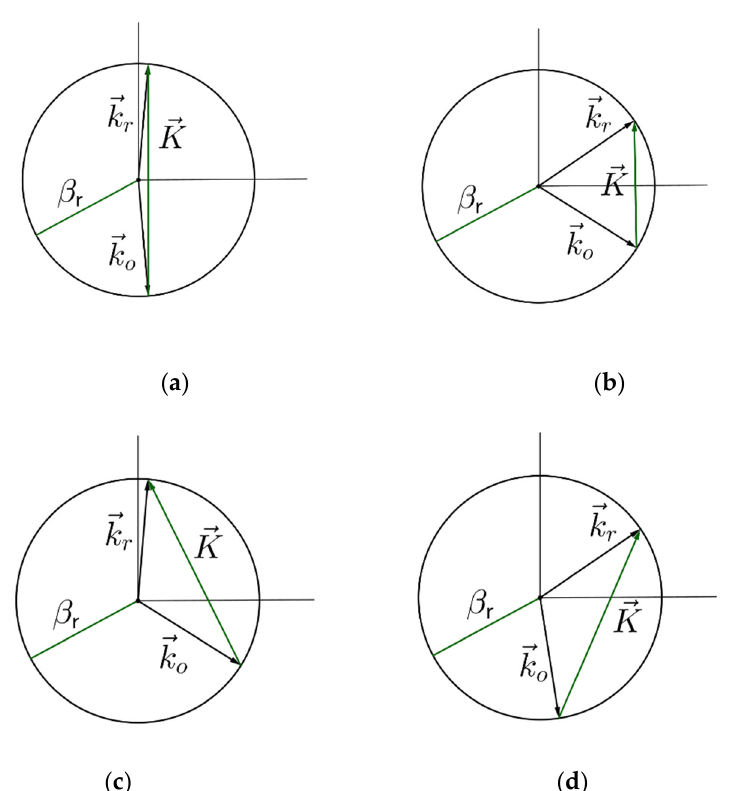
Figure 4. Noise gratings recorded in the photopolymer. ( a ) Noise grating due to the reference wave and its reflected counterpart. ( b ) Noise grating due to the object wave and its reflected counterpart. ( c ) Noise grating due to the reference wave and the reflected object wave. ( d ) Noise grating due to the object wave and the reflected reference wave.